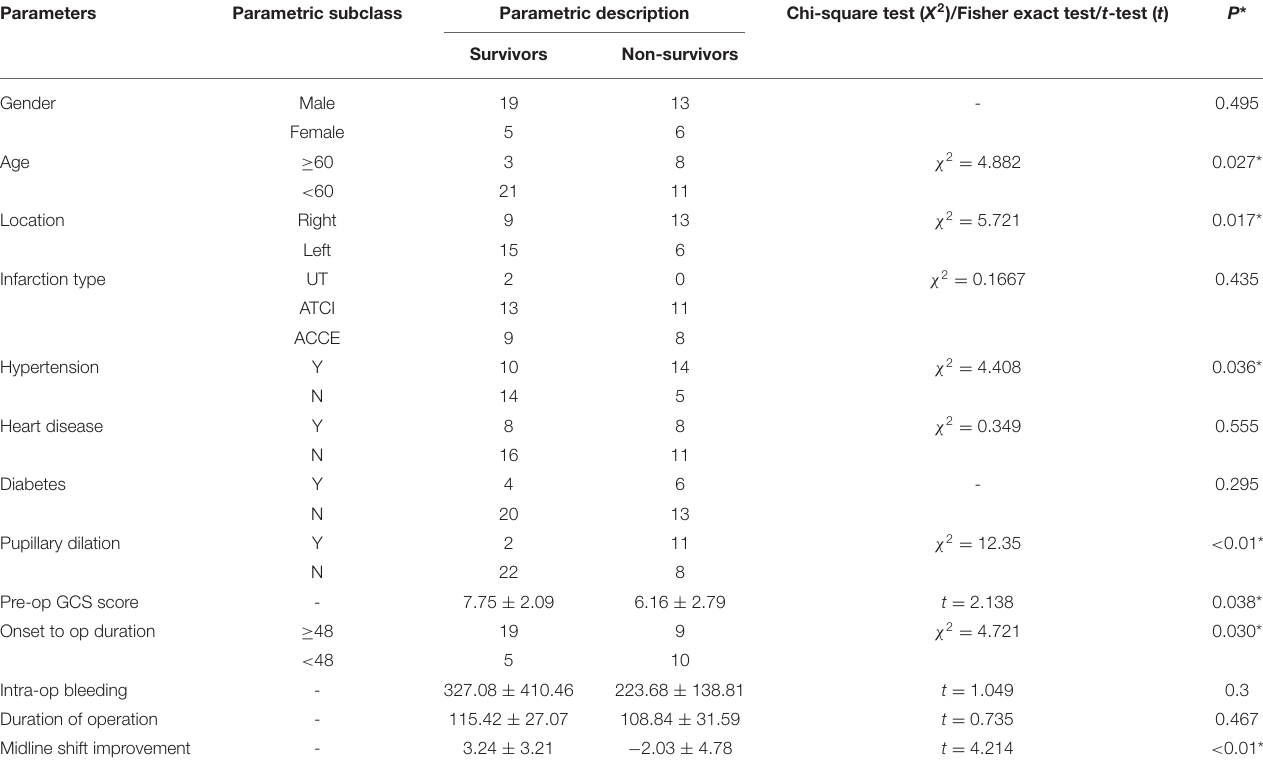
TABLE 1 | Univariate analysis shows the relationships between variables and 30-day mortality.